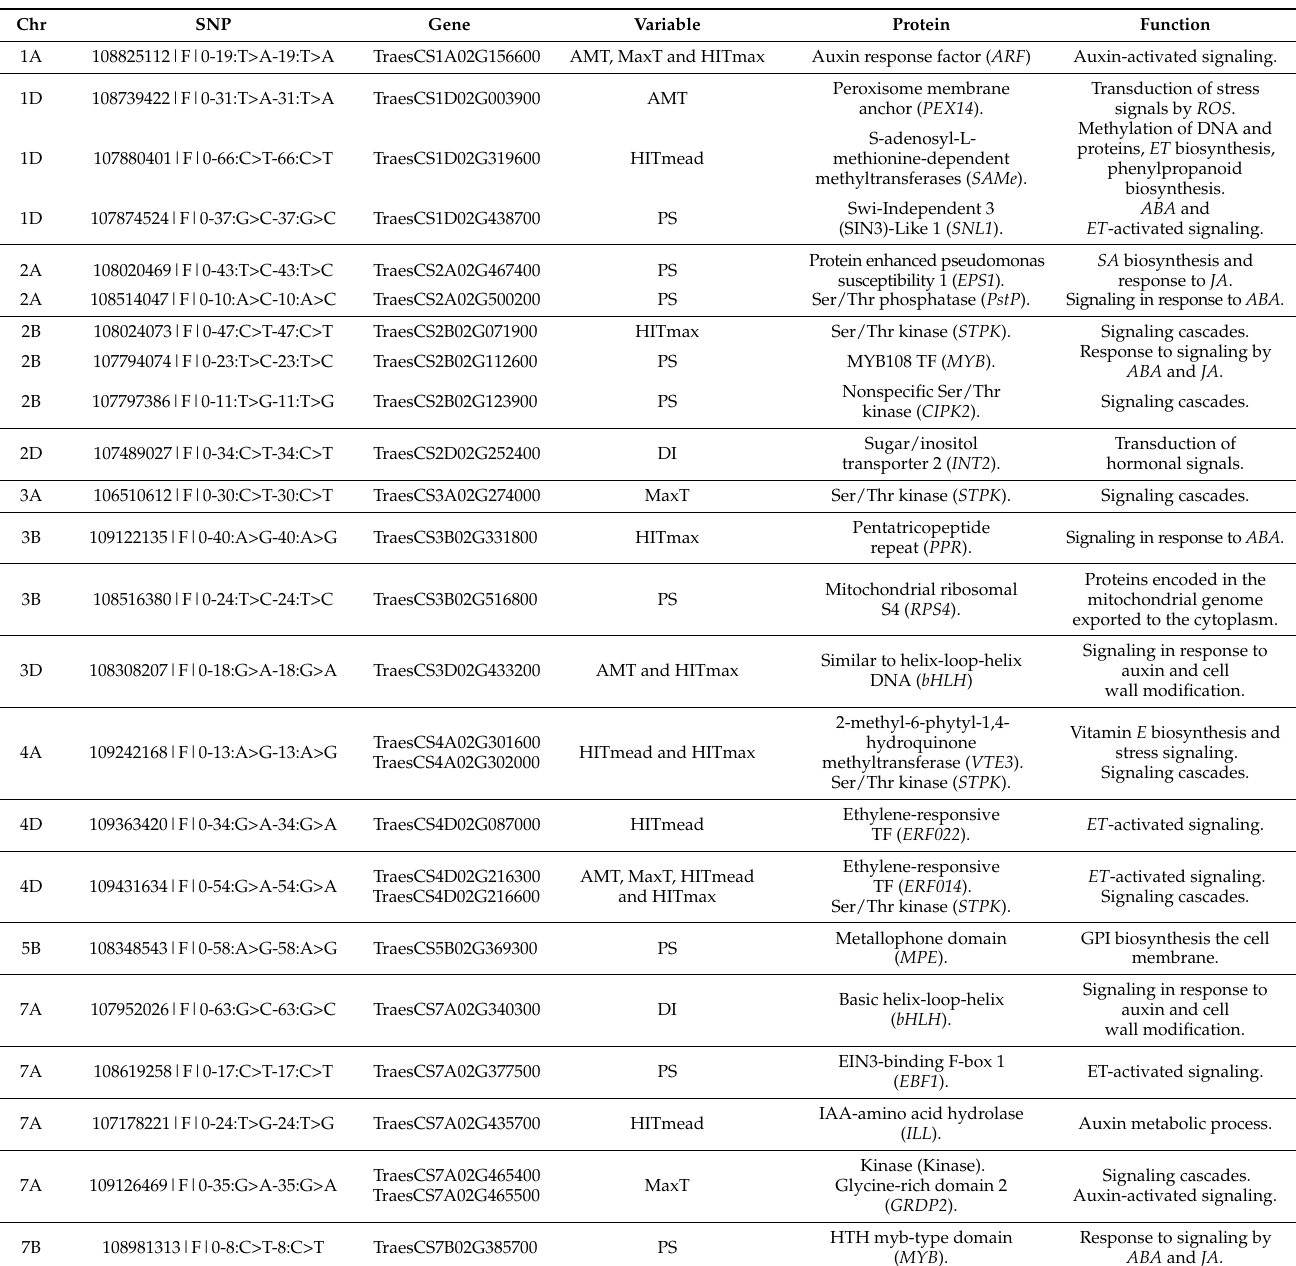
Table 3. Signaling genes and proteins identified for Genome–environment Associations (GEA) with seven climatic